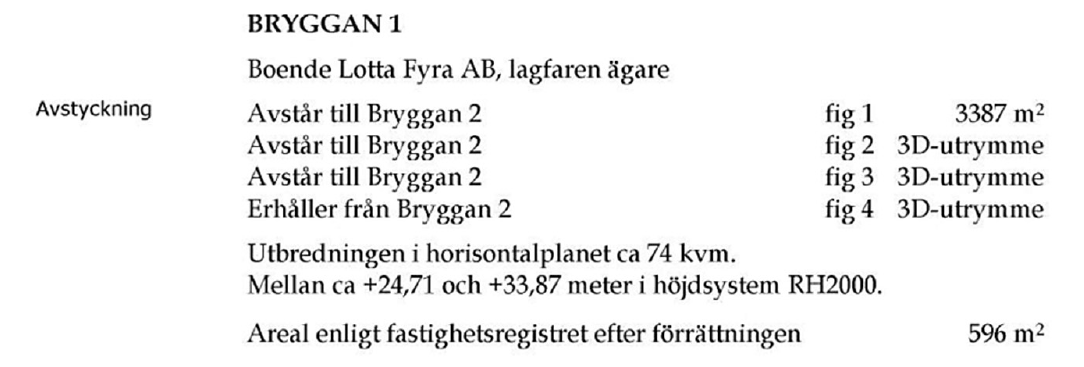
Figure 5. Parts of textual 3D information (in Swedish) in Multihuset cadastral document (Source: Malmö municipality).